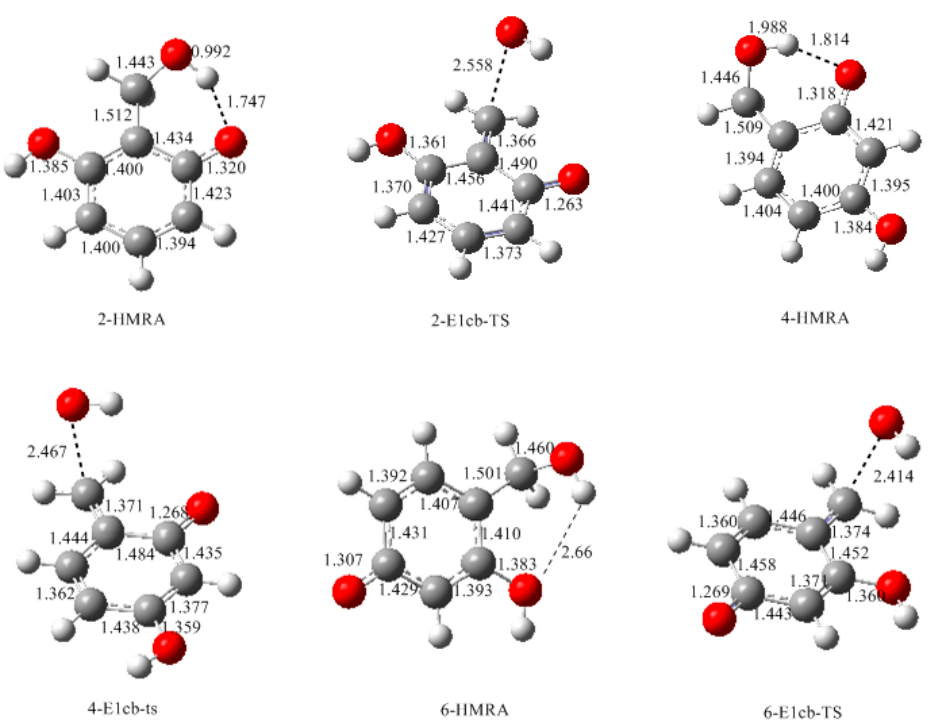
Figure 3. The calculated structures of the intermediates and transition states for E1cb formation of quinonemethide from hydroxymethyresorcinol anion.